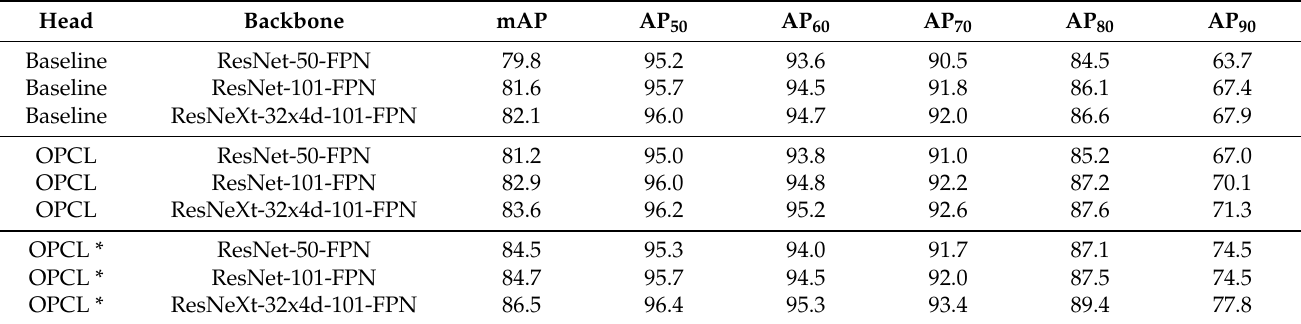
Table 3. Experimental results on LSCD. All the models are trained on LSCD trainval and evaluated on LSCD testing with the image scale of [600, 1000]. All the other settings are adopted as the same as the default settings provided in the MMDetection. The symbol “*” means that the gradient of OPCL with respect to IoU is computed during training.